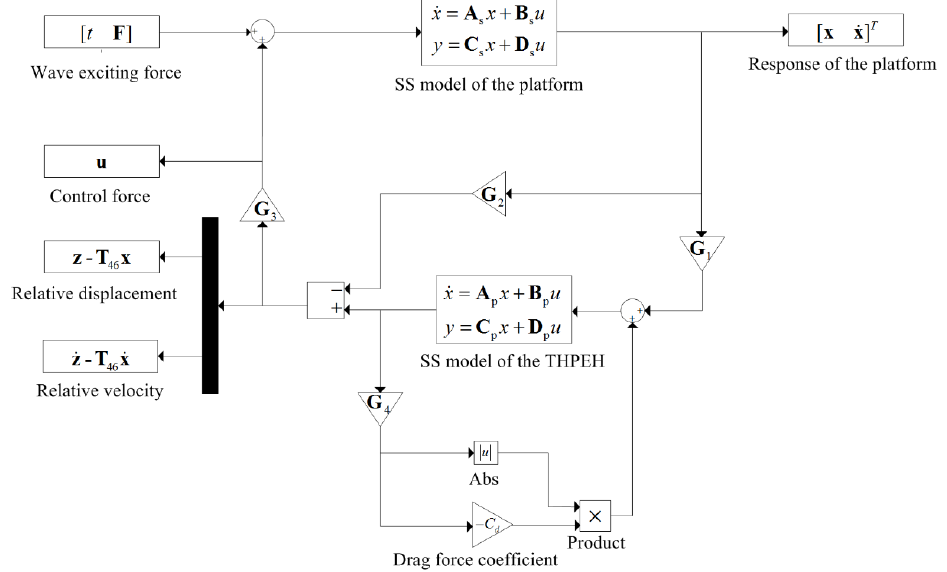
Figure 3. The diagram of the numerical model of the semi-submersible platform in the Simulink module.